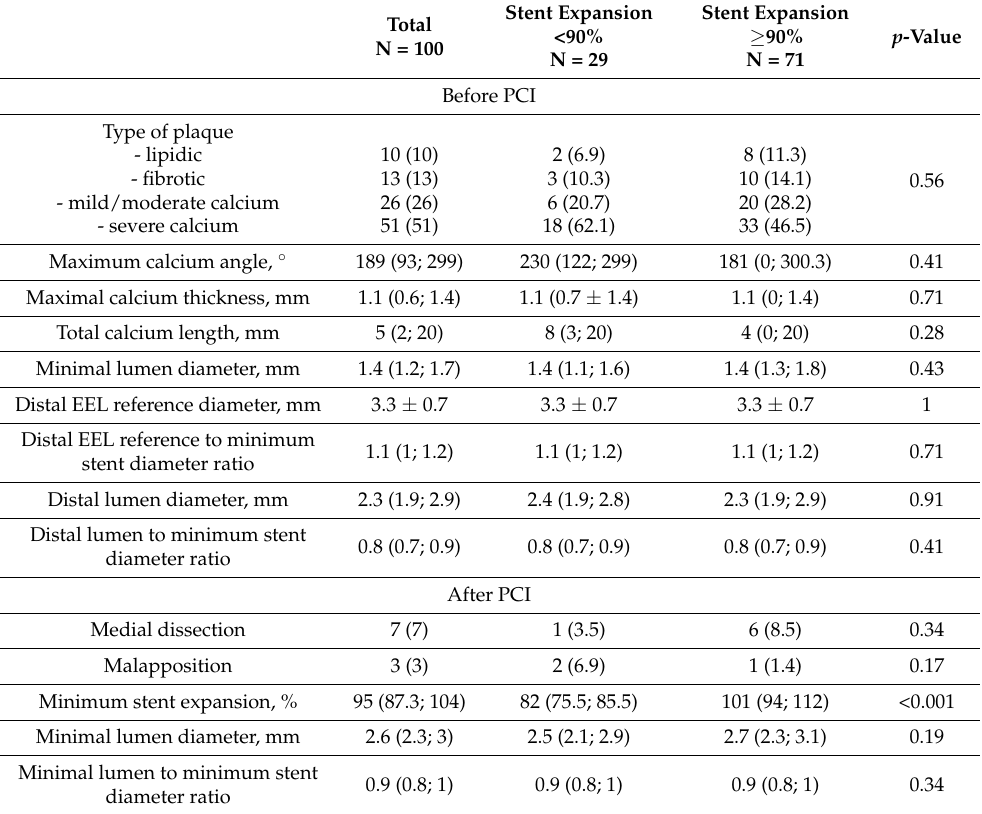
Table 4. Optical coherence tomography